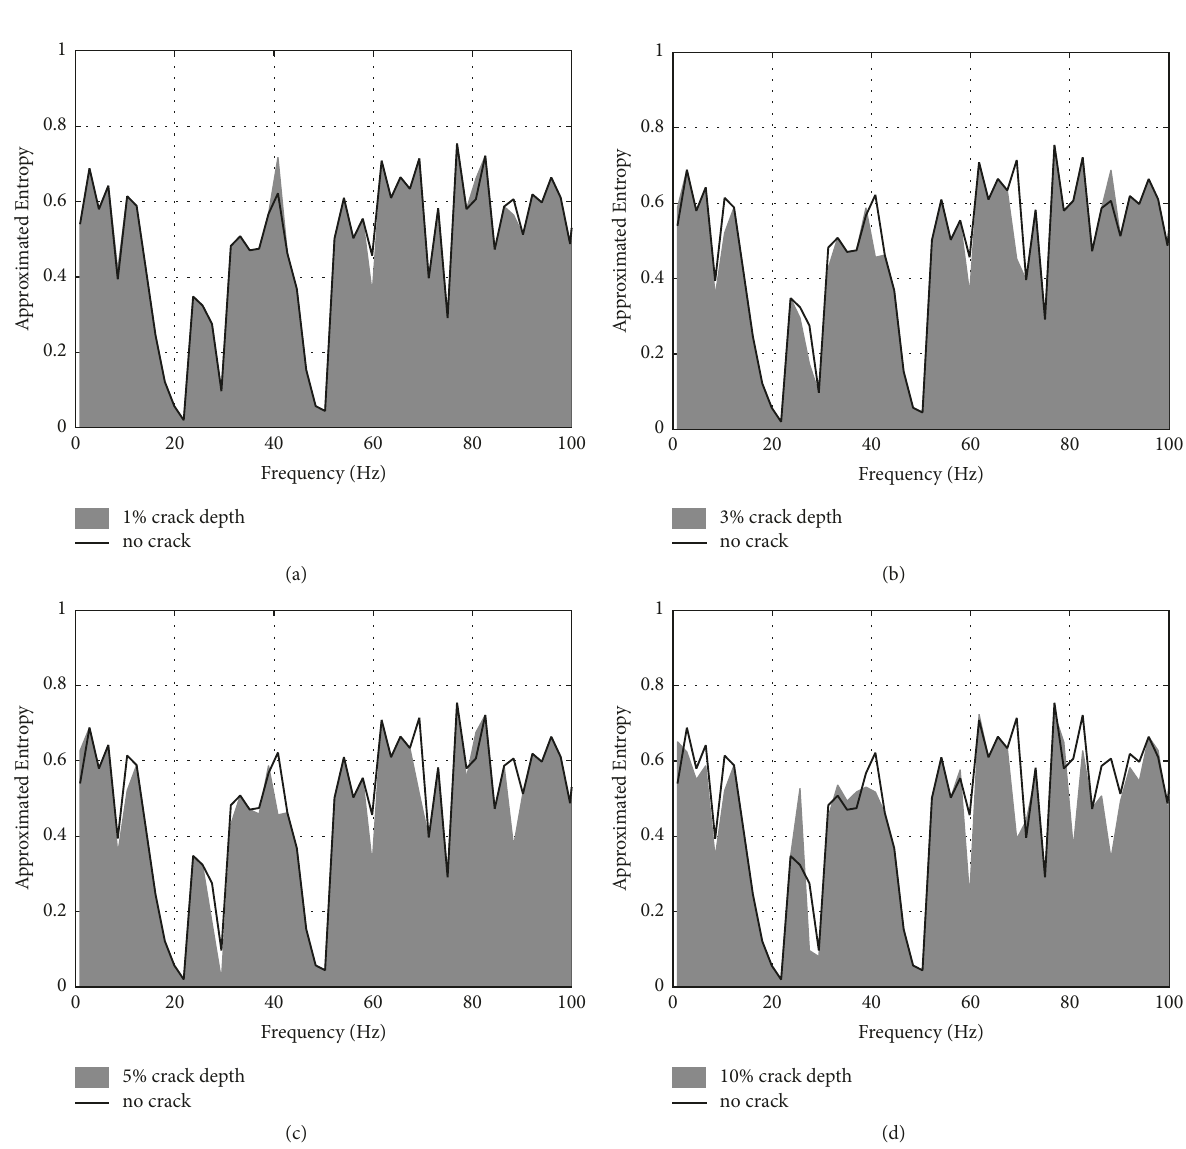
Figure 9: Approximated Entropy of the FFTs with noise (SNR = 1000, 𝑟 = 10 −5 ). Comparison between the cases of healthy and cracked shaft: (a) 1% crack depth; (b) 3% crack depth; (c) 5% crack depth; (d) 10% crack